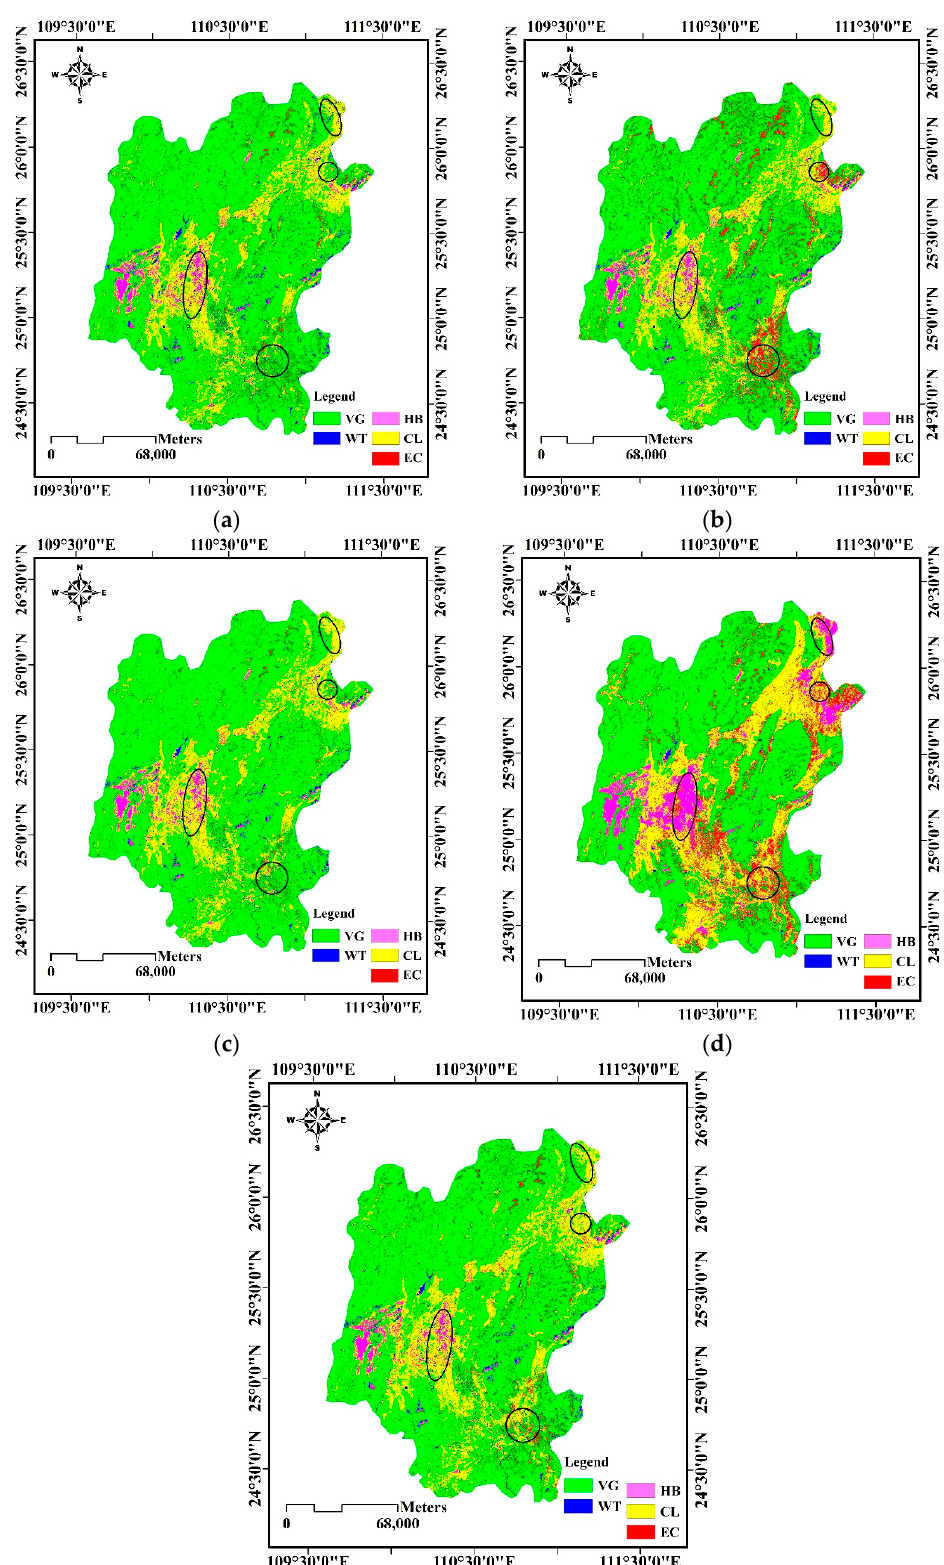
Figure 8. The results of classification in the first test area by: ( a ) the proposed method; ( b ) co-location decision tree (CL-DT); ( c ) stacked auto-encoders (SAE); ( d ) classification and regression tree (CART); and ( e ) random forests (RFs).